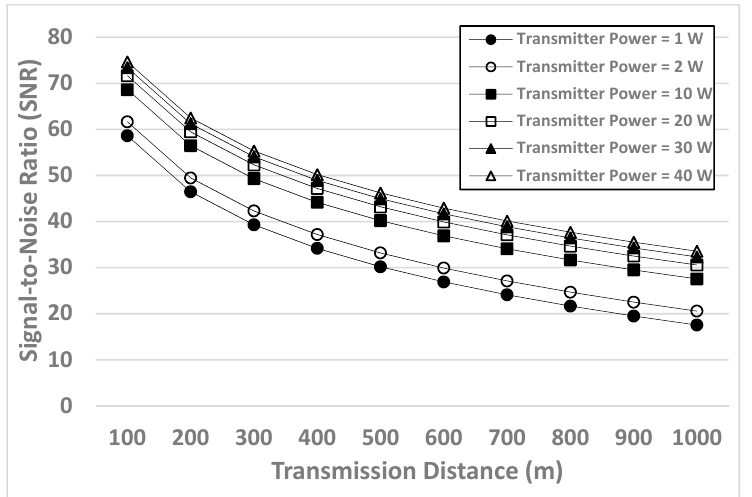
Figure 3. Simulation results of the Signal-to-Noise Ratio (SNR) when the channel models are applied to different transmitter powers (1–40 W) and distances (100–1000 m).